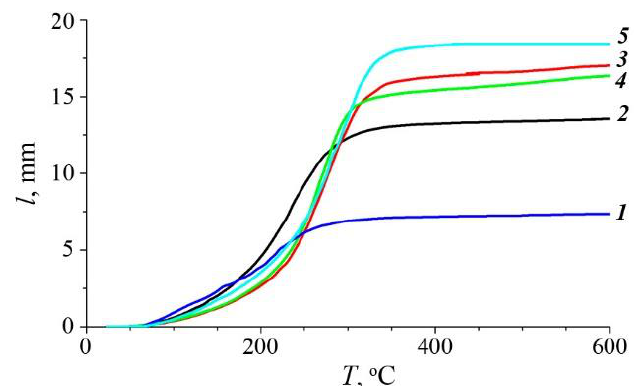
Figure 2. Variation of the recovery strain l (mm) of the 0.4C-18Mn-2Si-2V-steel sample in the process of the ε → γ transformation upon heating after preliminary quenching from 1150 ◦ C and aging at 720 ◦ C and cold deformation. Aging time: (1)—0; (2)—0.5; (3)—3; (4)—12; (5)—3 h (after the repeated quenching).